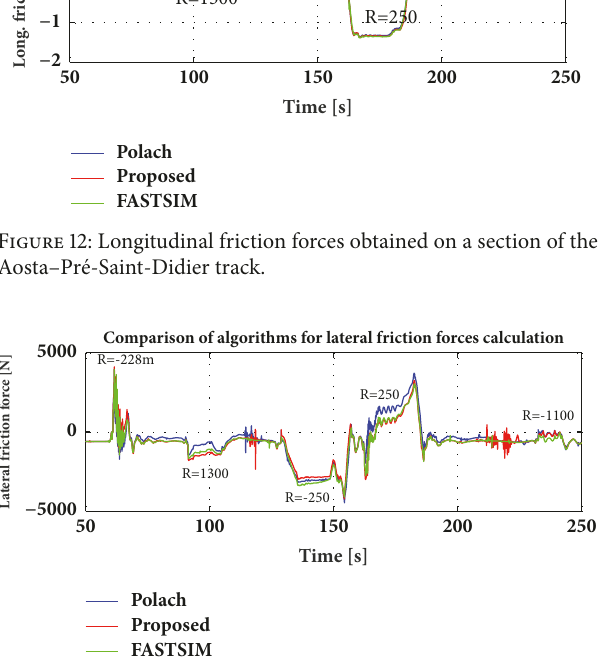
Figure 13: Lateral friction forces obtained on a section of the Aosta–Pr´e-Saint-Didier track. Table 7: Comparison of calculation time and number of rejected steps considering a simulation of 250